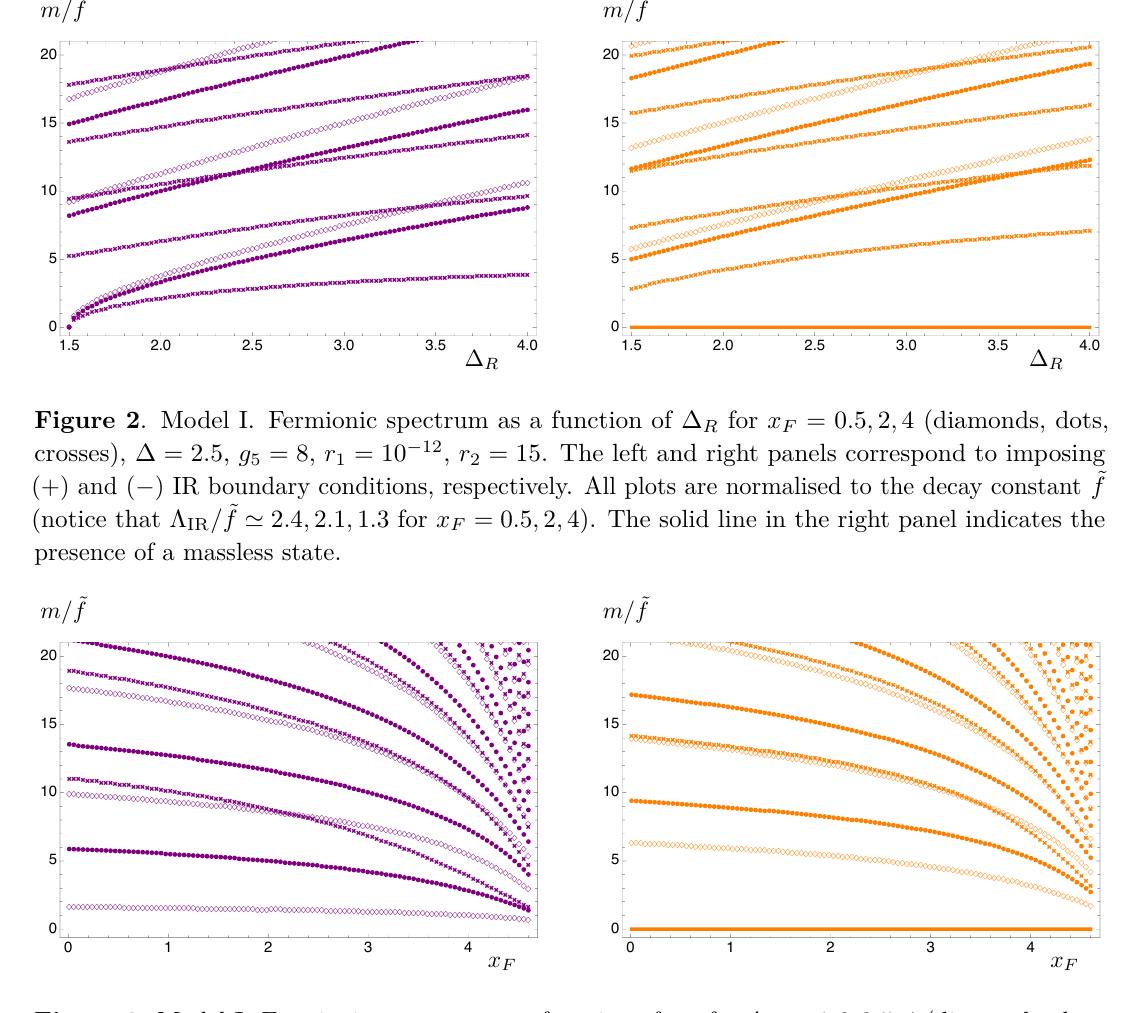
Figure 3 . Model I. Fermionic spectrum as a function of x F for ∆ R = 1 . 6 , 2 . 5 , 4 (diamonds, dots, crosses), ∆ = 2 . 5 , g 5 = 8 . In the numerics, we used the IR regulator r 1 = 10 − 12 for x F ≤ 4 . 3 , while for x F > 4 . 3 we used r 1 = 10 − 30 in order to minimize cutoff effects; in both cases, the UV regulator was chosen to be r 2 = 15 . The left and right panels correspond to imposing (+) and ( − ) IR boundary conditions, respectively. All plots are normalised to the decay constant ˜ f . The solid line in the right panel indicates the presence of a massless